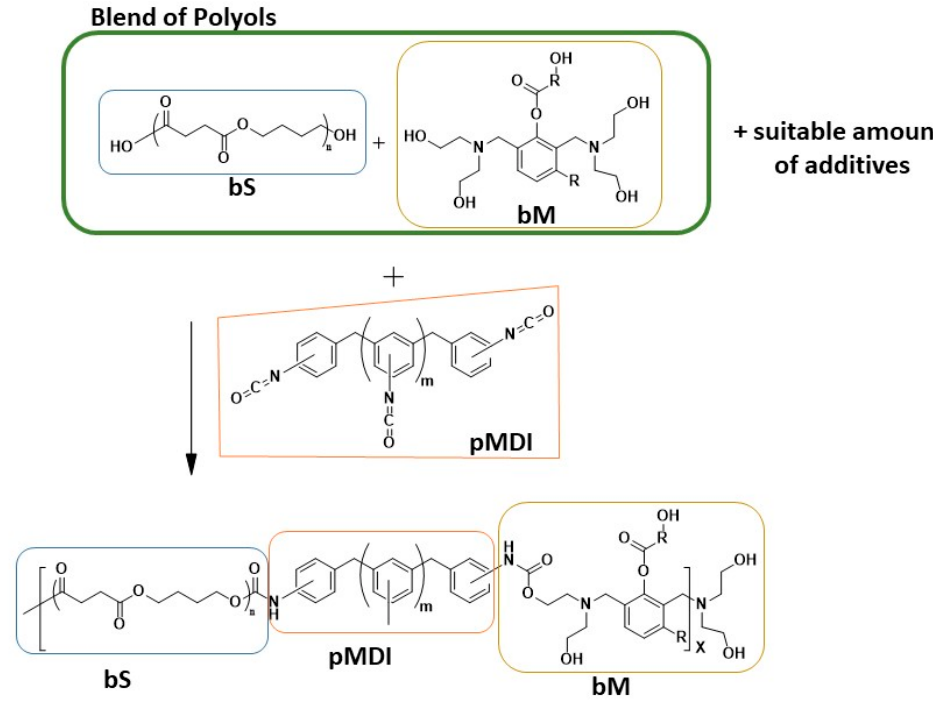
Figure 2. Sketch of general chemical structure based on bS and Mannich polyol (bM) polyols.